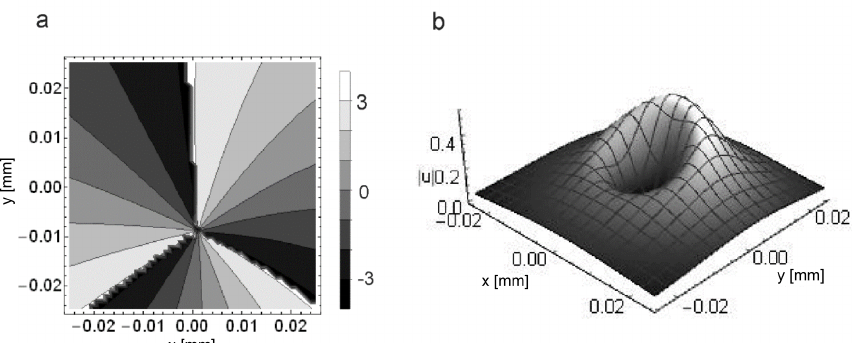
Figure 5. The vortex beam of m = 3 focused by the lens f 1 = 15 mm (according to Figure 2a); ( a ) phase and ( b ) amplitude distribution, calculated at z = 14.88 mm. Both distributions are evidently asymmetrical ( x c = 0.15 mm). Nevertheless, they do not split while propagating through the rest of the OVSM system.